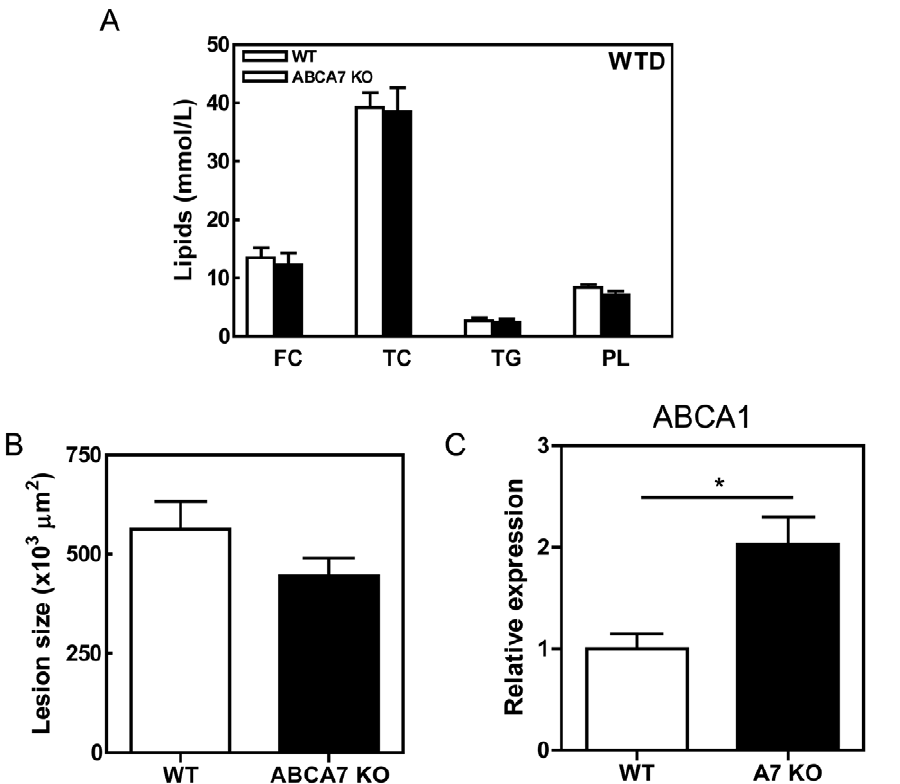
Figure 1. Effects of macrophage ABCA7 deficiency on plasma lipid levels, atherosclerosis and ABCA1 expression in peritoneal macrophages from LDLr KO mice reconstituted with WT and ABCA7 KO bone marrow. ( A ) Blood samples were drawn after an overnight fast. The concentrations of cholesterol, phospholipids and triglycerides in serum were determined using enzymatic colorimetric assays. ( B ) The mean lesion area ( m m 2 ) was calculated from Oil red O-stained cross-sections of the aortic root at the level of the tricuspid valves. ( C ) Guanidium thiocyanate-phenol was used to extract total RNA from cells and mRNA expression was determined by real-time RT-PCR. Hypoxanthine Guanine Phosphoribosyl Transferase (HPRT), b -actin, and acidic ribosomal phosphoprotein PO (36B4) were used as the standard housekeeping genes. Relative gene expression was calculated by subtracting the threshold cycle number (Ct) of the target gene from the average Ct of housekeeping genes and raising two to the power of this difference. Values represent the mean 6 SEM of $ 6 mice per group. Statistically significant difference *p , 0.05.